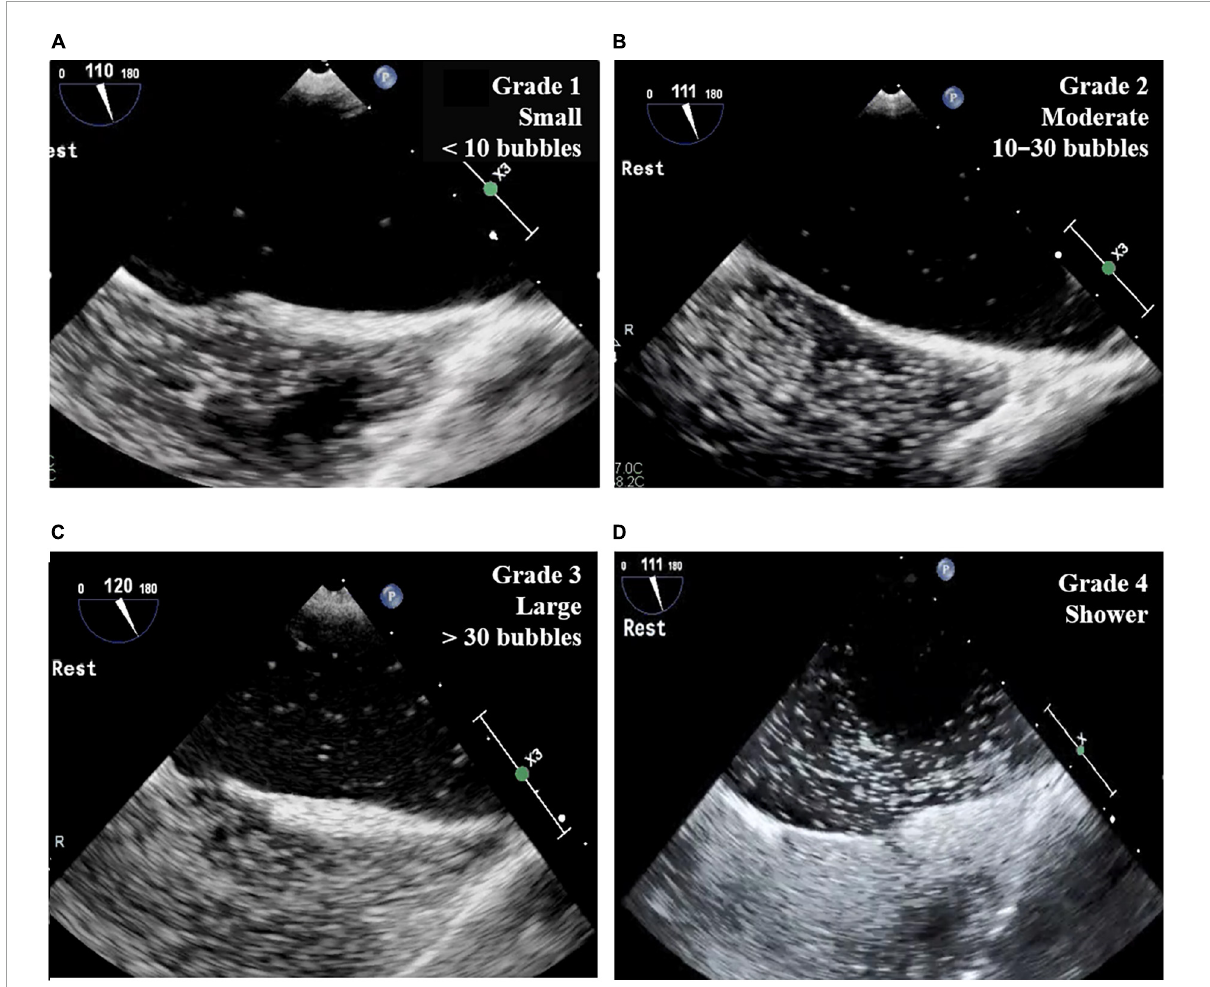
FIGURE2 Grade of TECE with agitated saline test. (A) Grade 1 (small): fewer than 10 bubbles in LA; (B) grade 2 (moderate): 10–30 bubbles in LA; (C) grade 3 (large): more than 30 bubbles in LA; (D) grade 4 (shower): extensive contrast in LA. TECE, transesophageal contrast echocardiography; LA, left